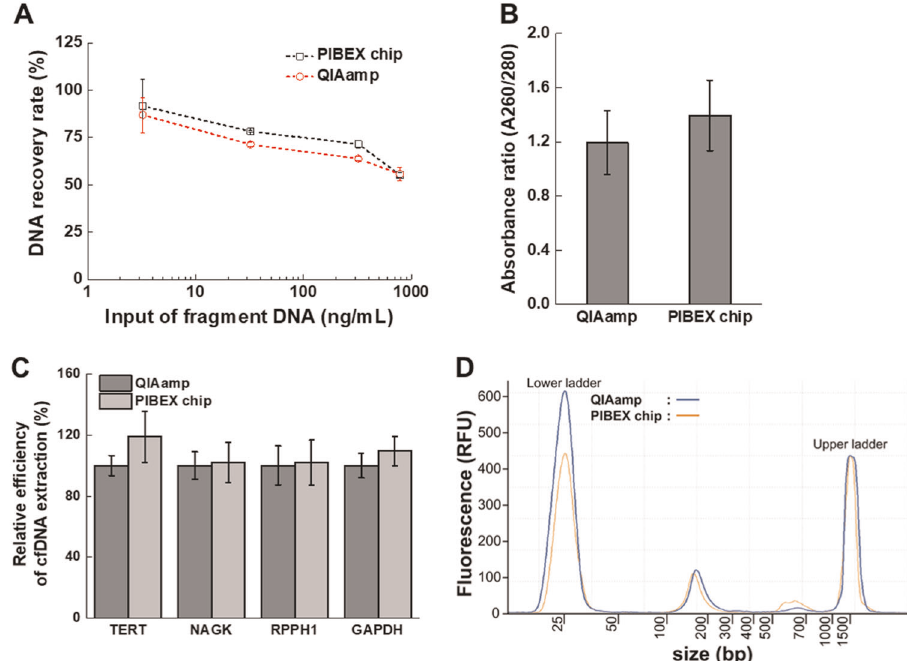
Fig. 3 Performance analysis of cfDNA extraction using a micro fl uidic PIBEX chip. The performance of cfDNA extraction in the PIBEX chip compared to the commercial product QIAamp. a DNA recovery rates according to input of fragment DNA was investigated in three experiments. b Purity of fi nal eluents was compared by absorbance ratio at A260/280 ( n = 5). c Relative ef fi ciency of cfDNA extraction in healthy plasma sample was measured by real-time PCR with the four reference genes: TERT , NAGK , RPPH1 , and GAPDH . The relative ef fi ciency was calculated based on cfDNA extraction in QIAamp ( n = 8). d Size analysis of extracted DNA from human plasma of healthy control was measured by microelectrophoresis. The error bars indicate standard